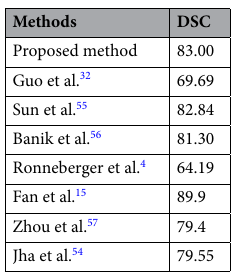
Table 4. Comparison the results of the proposed model with state-of-the-art results on CVC-ClinicDB dataset.